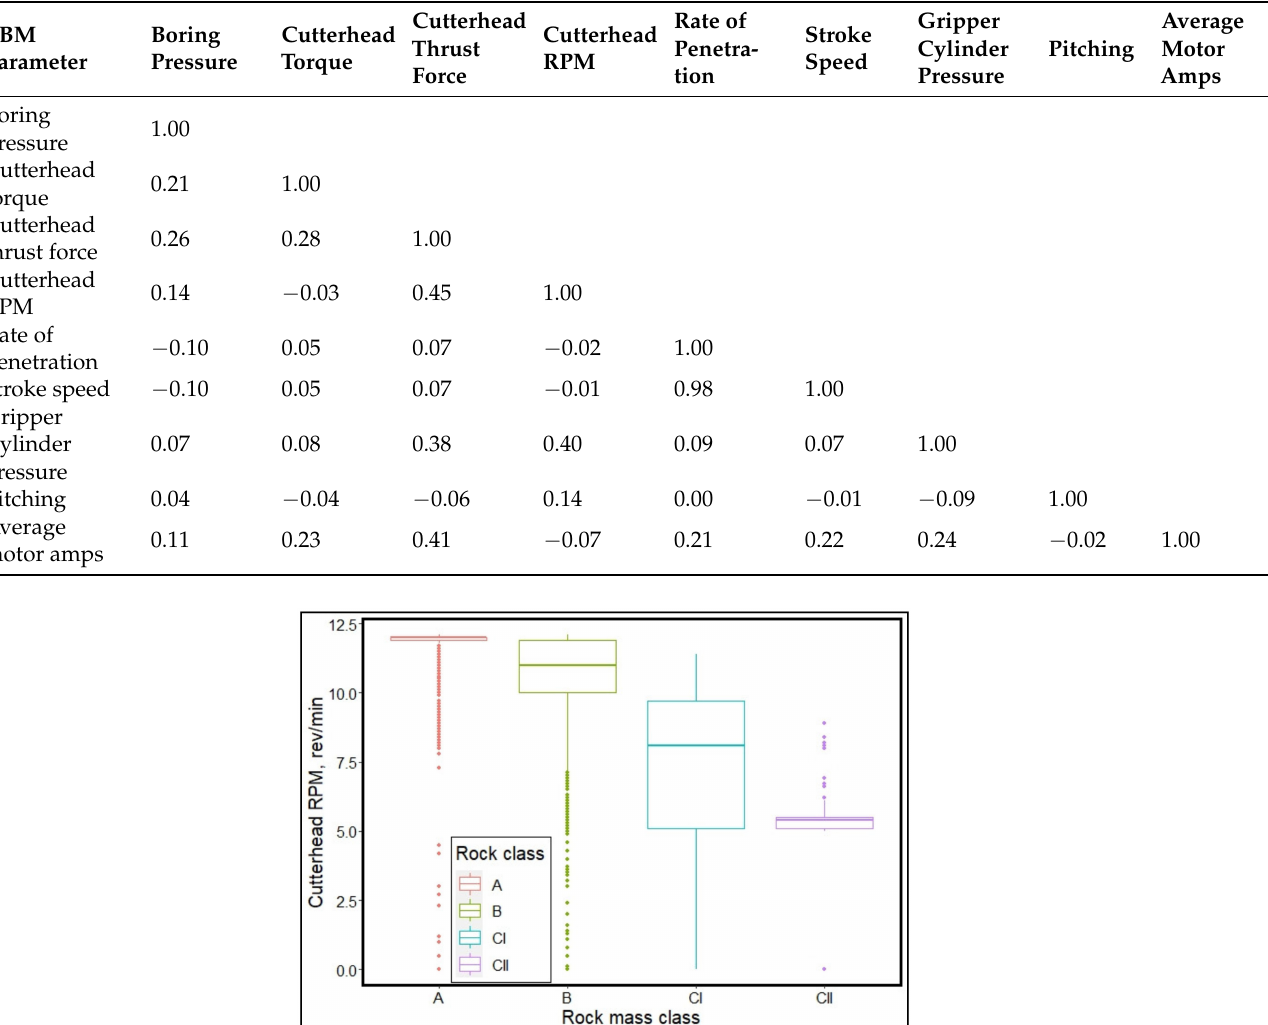
Table 4. Pairwise correlation of some input variables.